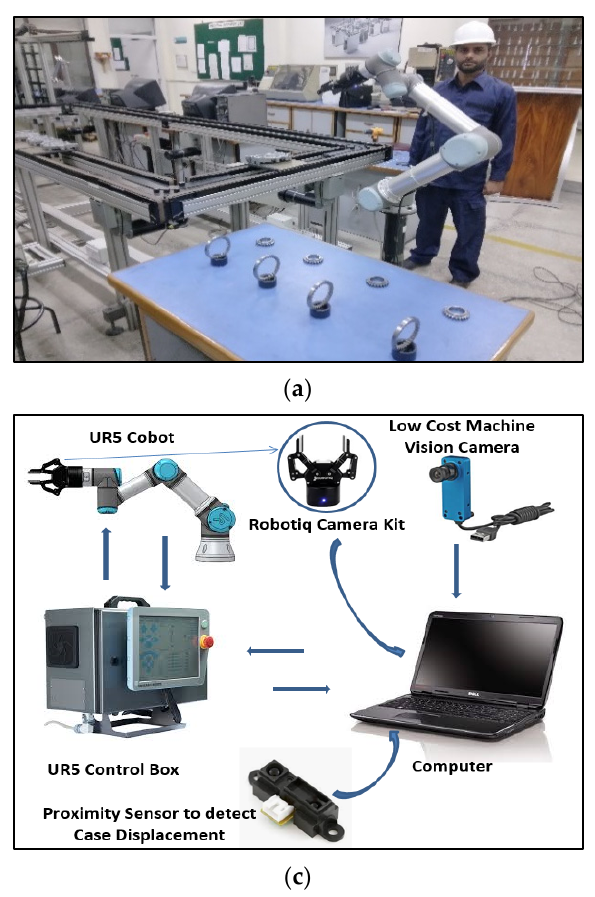
Figure 3. ( a ) Experimental Case 1; ( b ) Experimental Case 2; ( c ) Interface of CPPS